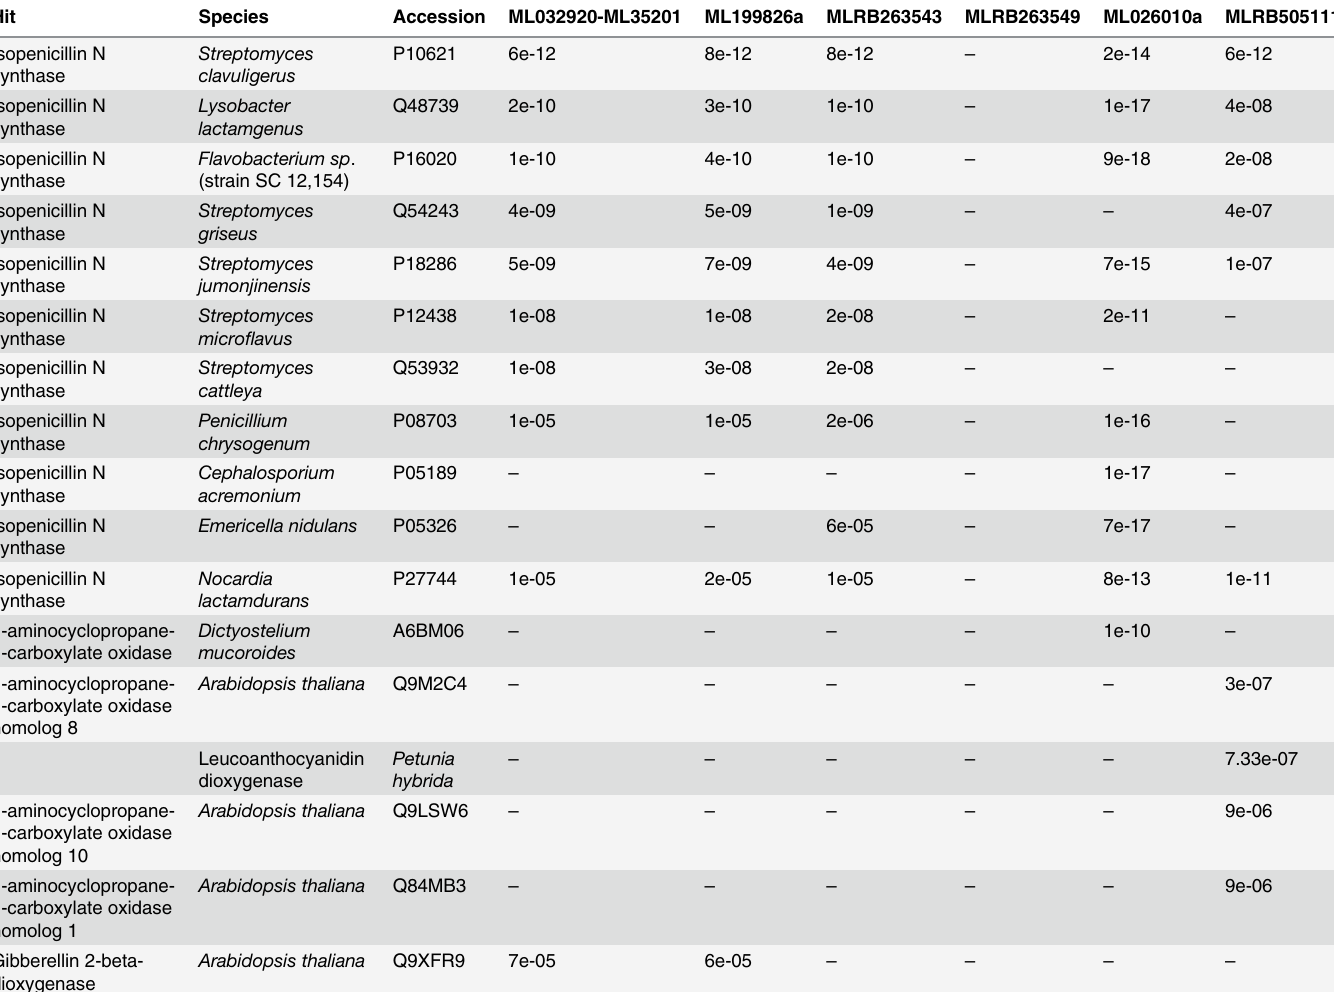
Table 4. Top BLAST hits for FYY proteins in Swissprot.